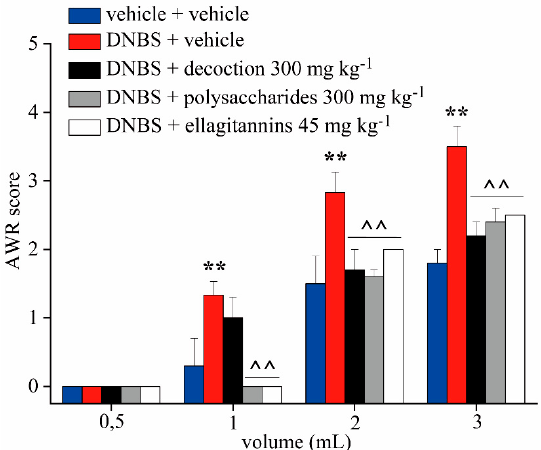
Figure 3. Effect of repeated treatment with pomegranate-based preparations on behavioral alterations related to pain perception. Behavioral responses to CRD were assessed Abdominal Withdrawal Reflex (AWR) measurement, using a semiquantitative score in conscious animals. Tests were performed 14 days after DNBS administration in awake animals. Each value is the mean ± S.E.M. and represents the mean of six rats per group. ** p < 0.01 vs. vehicle + vehicle treated animals ˆˆ p < 0.01 vs. DNBS + vehicle treated